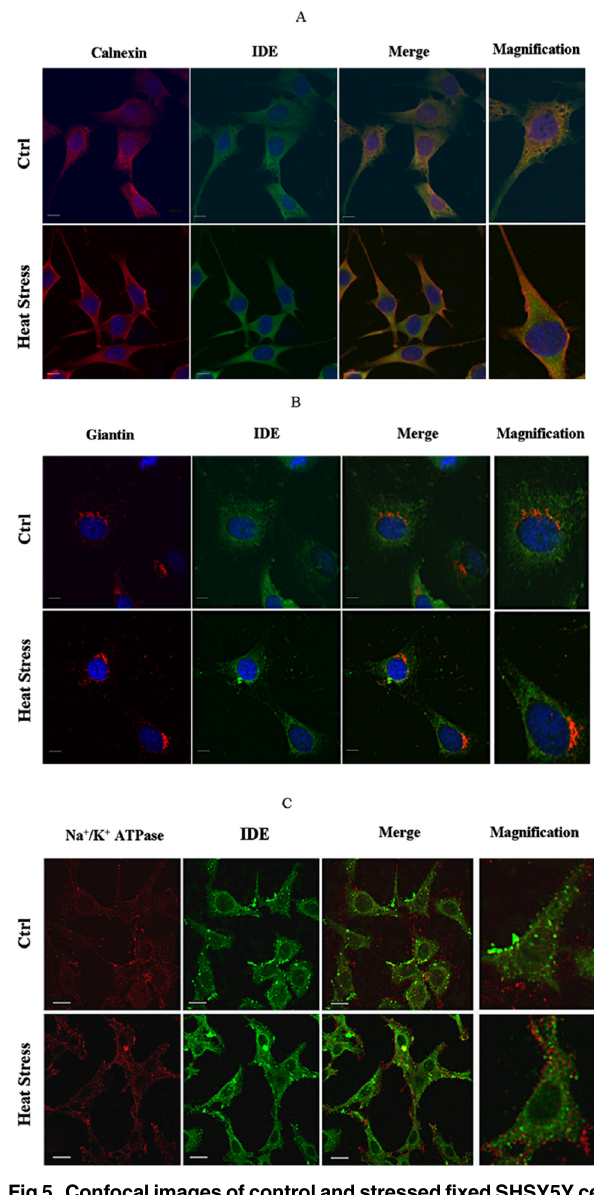
Fig 5. Confocal images of control and stressed fixed SHSY5Y cells 24 h after heat administration. Cell localization of IDE was determined using anti-IDE mouse monoclonal (A and B) or anti-IDE rabbit polyclonal (C) antibodies. The Endoplasmic Reticulum was stained with anti-calnexin (A), while Golgi was labelled with anti-giantin rabbit polyclonal antibody (B). Plasma membrane was stained with anti-Na + / K + -ATPase mouse monoclonal antibody (C) Nuclei were counterstained with DAPI (blue)(A,B). Bars correspond to 20